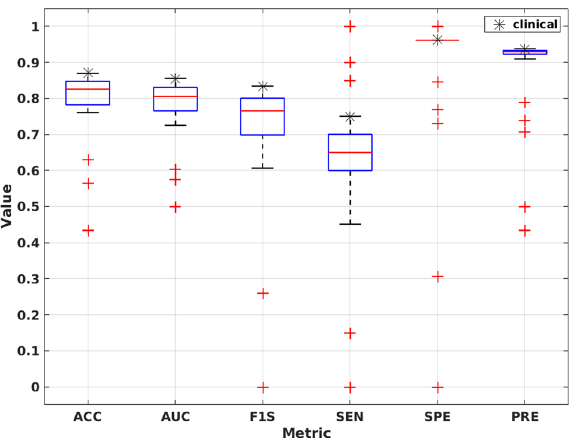
Figure 6. CNN classification performance from 100 runs of the network versus the clinical interpretation. The best classification results of the CNN match the performance of clinical interpretation ACC = accuracy, AUC = area under the receiver operating characteristic curve, F1S = F1 score, SEN = sensitivity, SPE = specificity, PRE = precision.